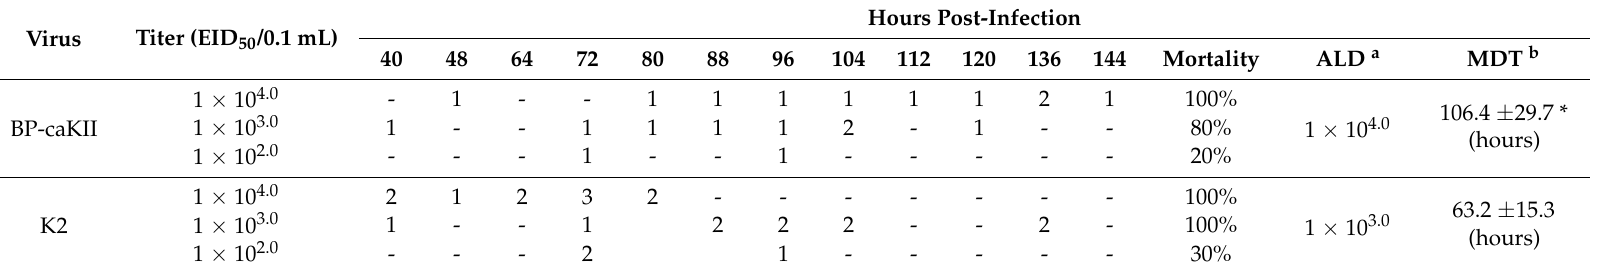
Table 2. Comparison of embryonic pathogenicity of BP-caKII with K2.